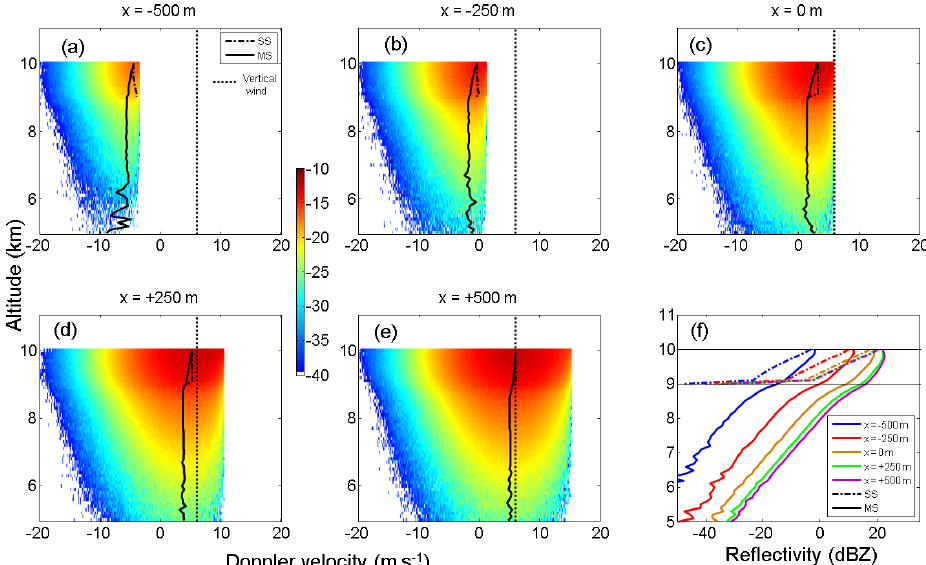
Figure 7. Vertical profiles of MS radar Doppler spectra (logarithm of the spectral density; in m − 1 sr − 1 (ms − 1 ) − 1 ) in the CPR/EarthCARE configuration corresponding to the five positions x = − 500m (a) , x = − 250m (b) , x = 0m (c) , x = + 250m (d) , and x = + 500m (e) of the satellite relative to the edge of the box cloud. SS (black line) and MS (black dotted line) vertical profiles of Doppler velocity are superimposed. The vertical wind velocity profile (downdraft) fixed at w wind = 6ms − 1 during our simulation is also drawn (black dotted line). (e) The five reflectivity (in dBZ) profiles (MS: full lines, SS: dotted lines) corresponding to the five positions ( x = − 500 in blue, x = − 250 in red, x = 0m in brown, x = 250m in green, and x = 500m in magenta) relative to the edge of the box cloud. Cloud optical depth is 3.